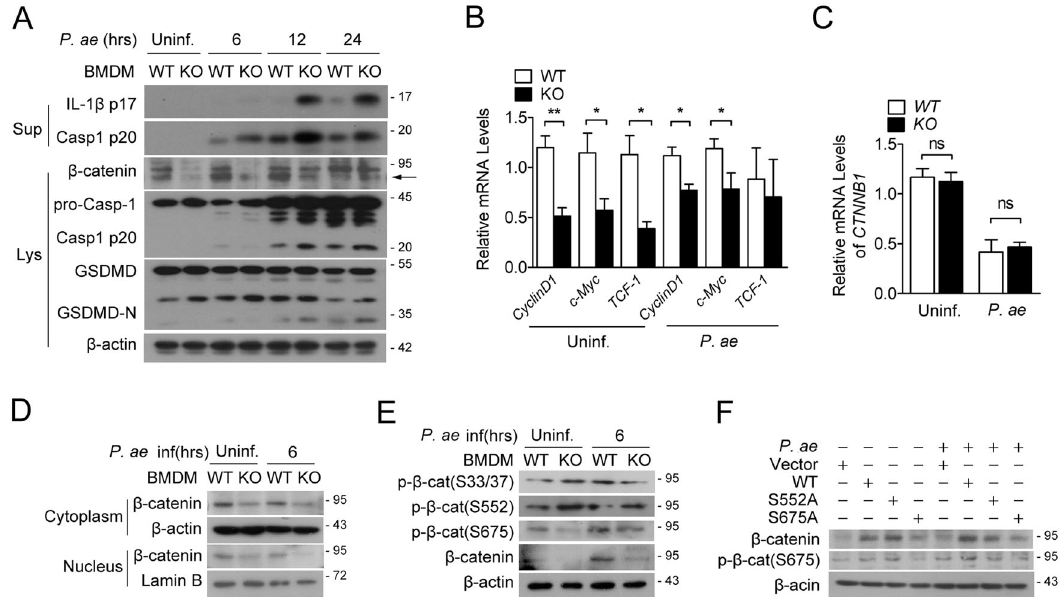
Fig. 4 TREM2 promotes β -catenin stability and phosphorylation. A – E TREM2 KO vs. WT BMDMs were infected by Pseudomonas aeruginosa (MOI = 1) for indicated times. F RAW264.7 cells were transiently transfected with pcDNA3.1 vector or plasmids encoding WT or mutant (S552A or S675A) β -catenin, followed by Pseudomonas aeruginosa infection. A , D , E , F Protein levels of indicated molecules in cell lysates, cytoplasm, nucleus or supernatants of each group were detected by western blot. B , C mRNA levels of indicated genes were detected by real-time PCR. Data are presented as the mean ± SEM of three independent experiments. * P < 0.05; ** P < 0.01. ns no signi fi